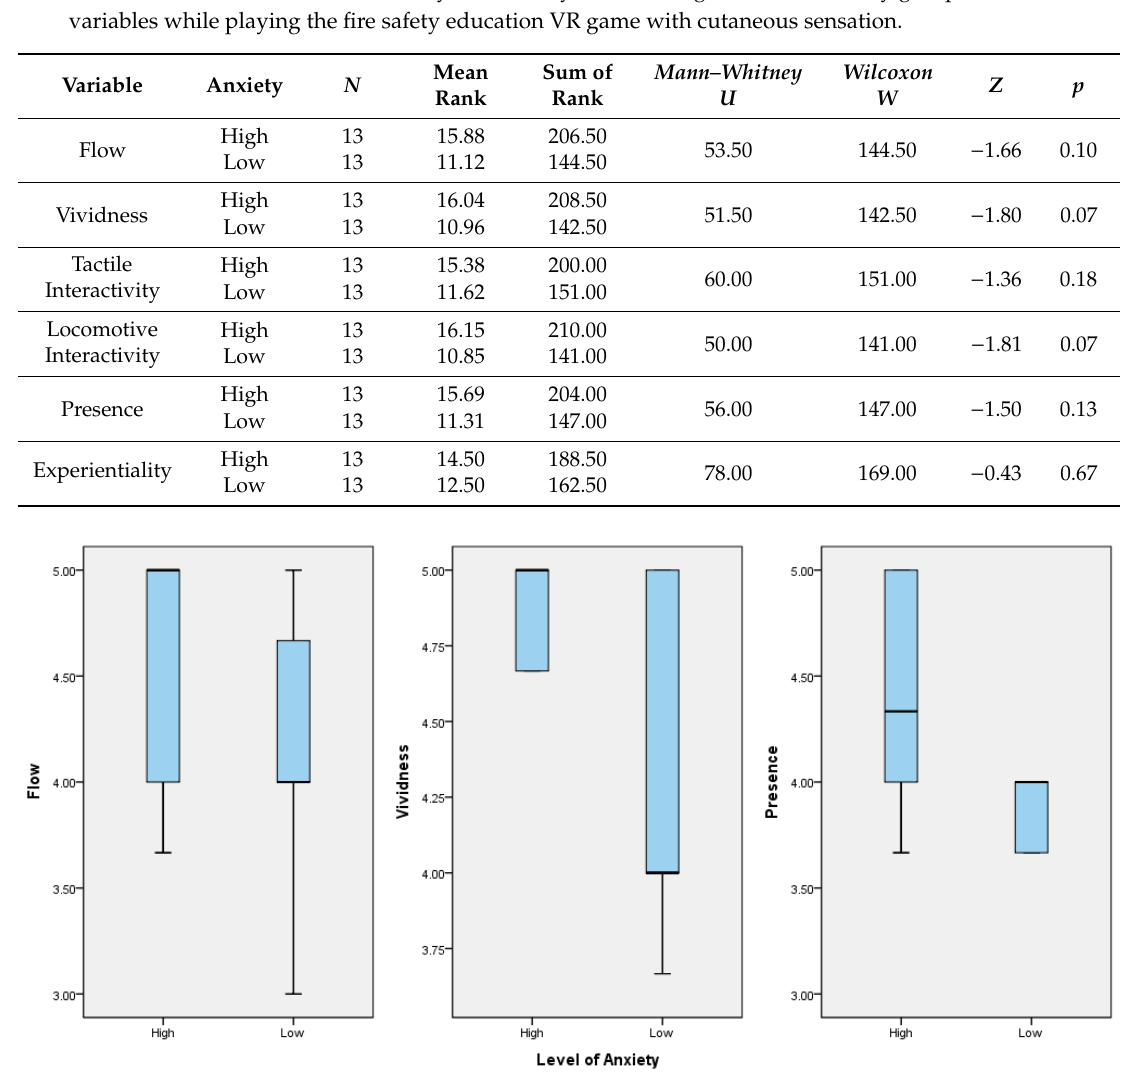
Figure 3. Comparison of the boxplots for the high- and low-anxiety groups for the flow, vividness, and presence variables while playing the fire safety education VR game with cutaneous sensation.